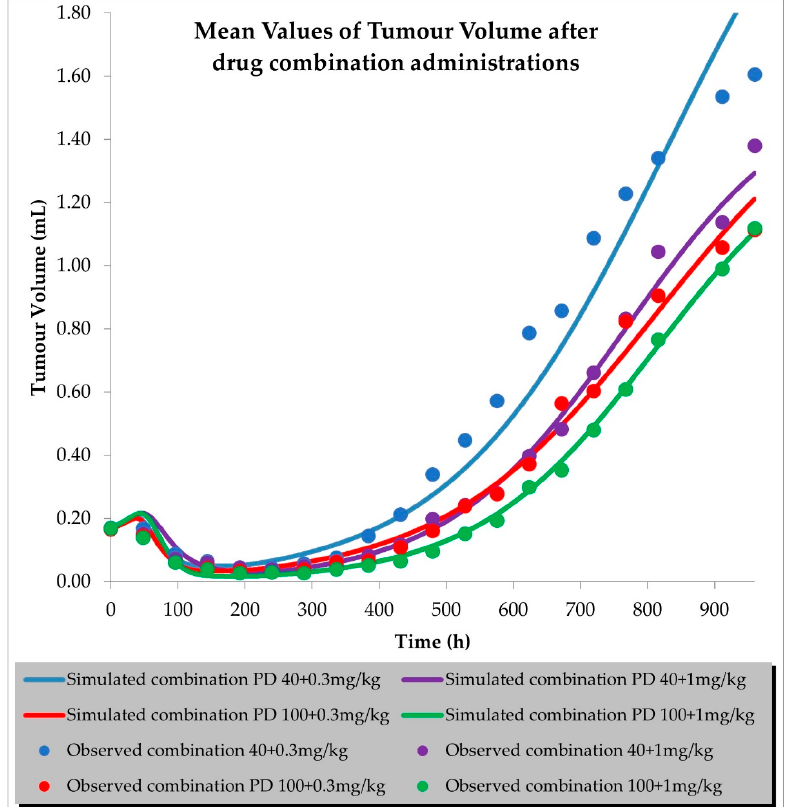
Figure 9. Tumour volume simulations after combined drug administration of siremadlin and trametinib. Observed data are means from n = 6.